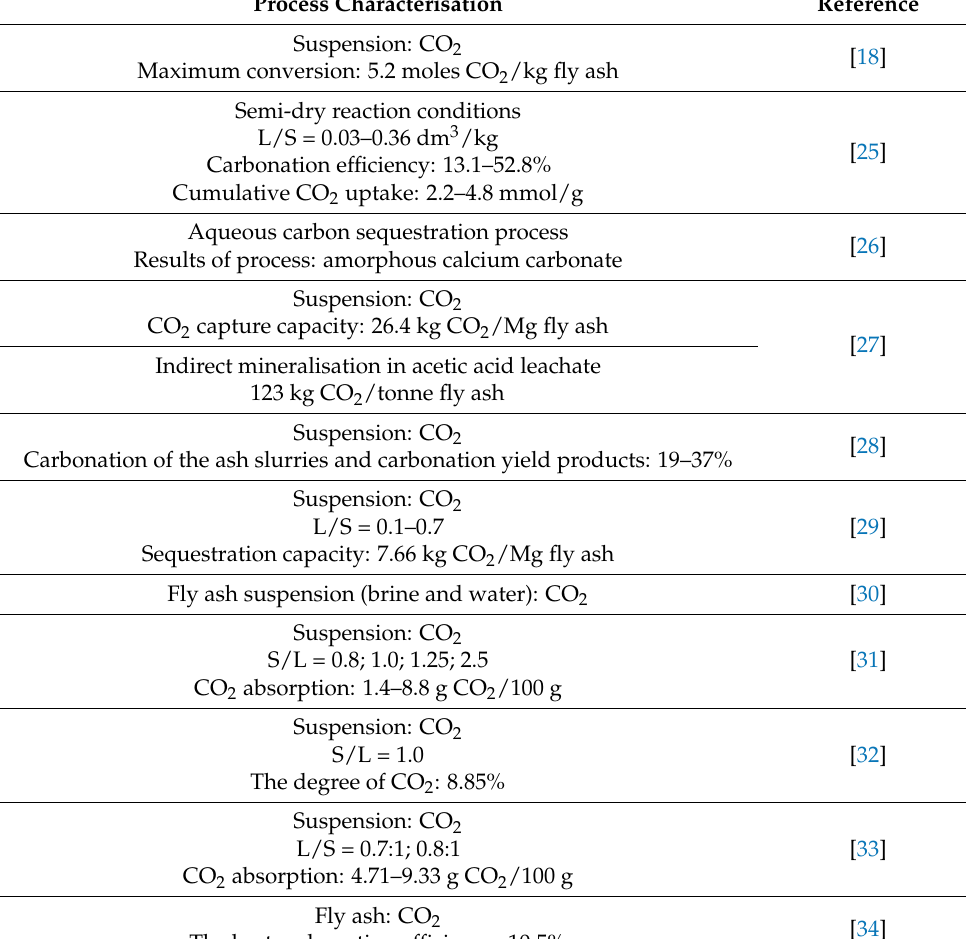
Table 1. Mineral sequestration of CO 2 using lignite fly